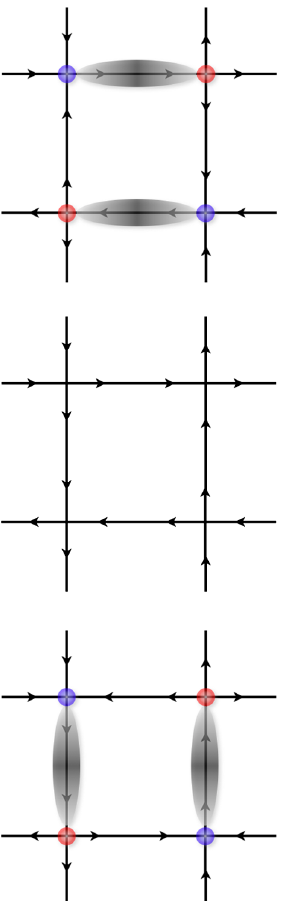
FIG. 8. A sequence of Metropolis updates in the monopole- crystal phase of a dumbbell model on a square lattice. The gray ellipses show the fictive dimer positions, and the blue and red circles signify north and south poles, respectively. The chevrons show the needle orientations along the bonds. The sequence of moves simulates a hard-core dimer flip on a square plaquette.